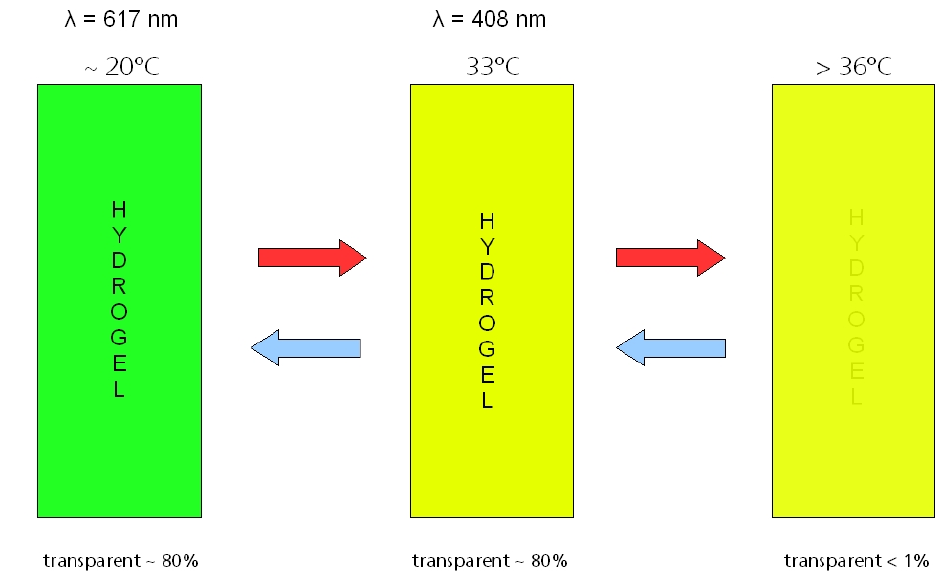
Figure 10. Course of color and transmittance in a system from polyalkoxide/LiCl/ bromothymol